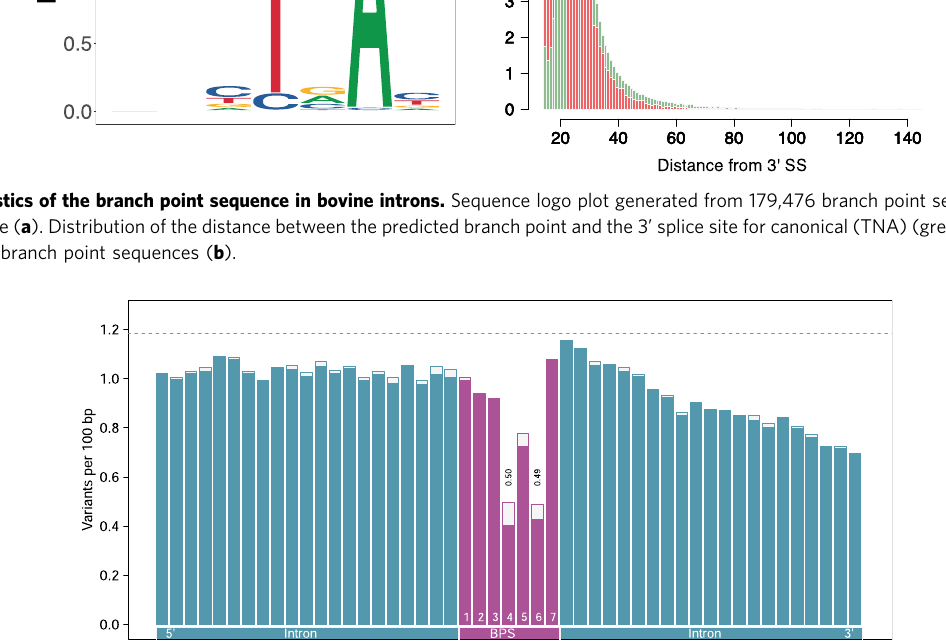
Fig. 4 Local variation at the bovine branch point sequence (BPS). The height of the bars indicates the variation (variants per 100 bp) surrounding 179,476 branch points while the solid bars indicate the variation surrounding a subset of 162,377 branch points encompassed by heptamers with a canonical “ TNA ” motif. The dotted horizontal red line indicates the average genome-wide